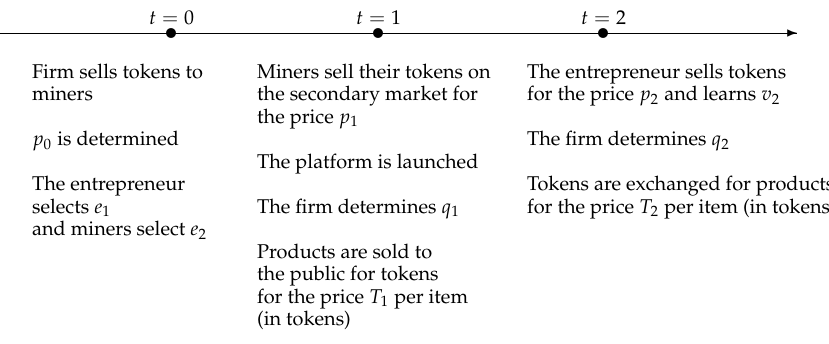
Figure 3. The sequence of events with moral hazard and market uncertainty for utility